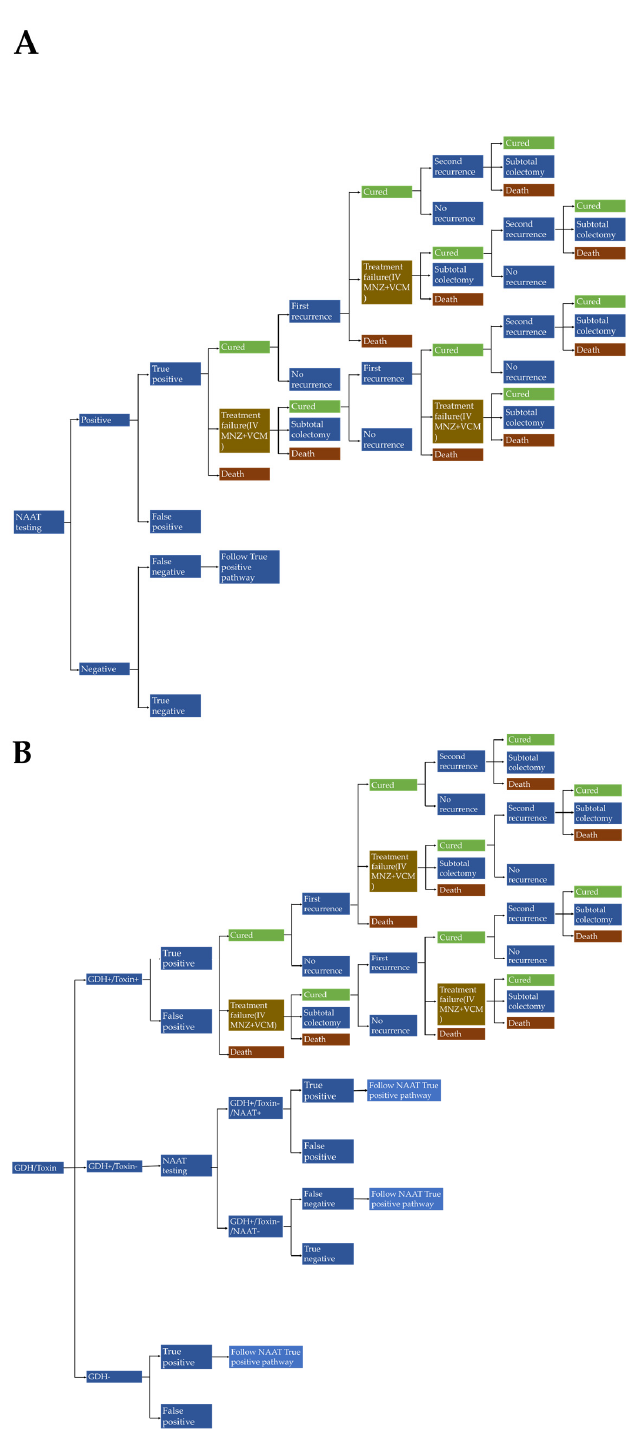
Figure 2. Decision tree of CDI diagnostic strategies. ( A ) Decision tree of one‑step NAAT alone path‑ way; ( B ) Decision tree of two‑step algorithm with GDH/toxin followed by NAAT. Patients with